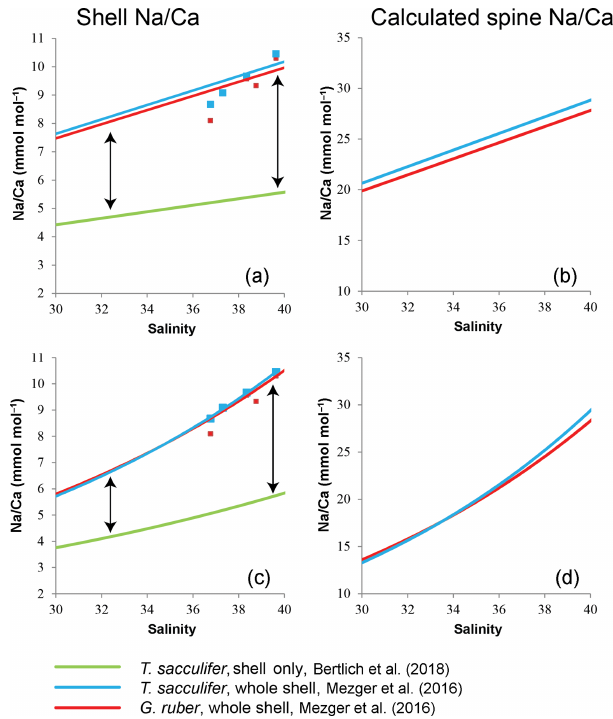
Figure 9. Comparison of Na / Ca-salinity calibrations between surface-water-collected spinose planktonic specimens still contain- ing spines (whole-shell) (Mezger et al., 2016) and extrapolated cul- tured shell-only T. sacculifer (Bertlich et al., 2018). The difference in absolute values is assumed to be caused by spines (arrow) (a)